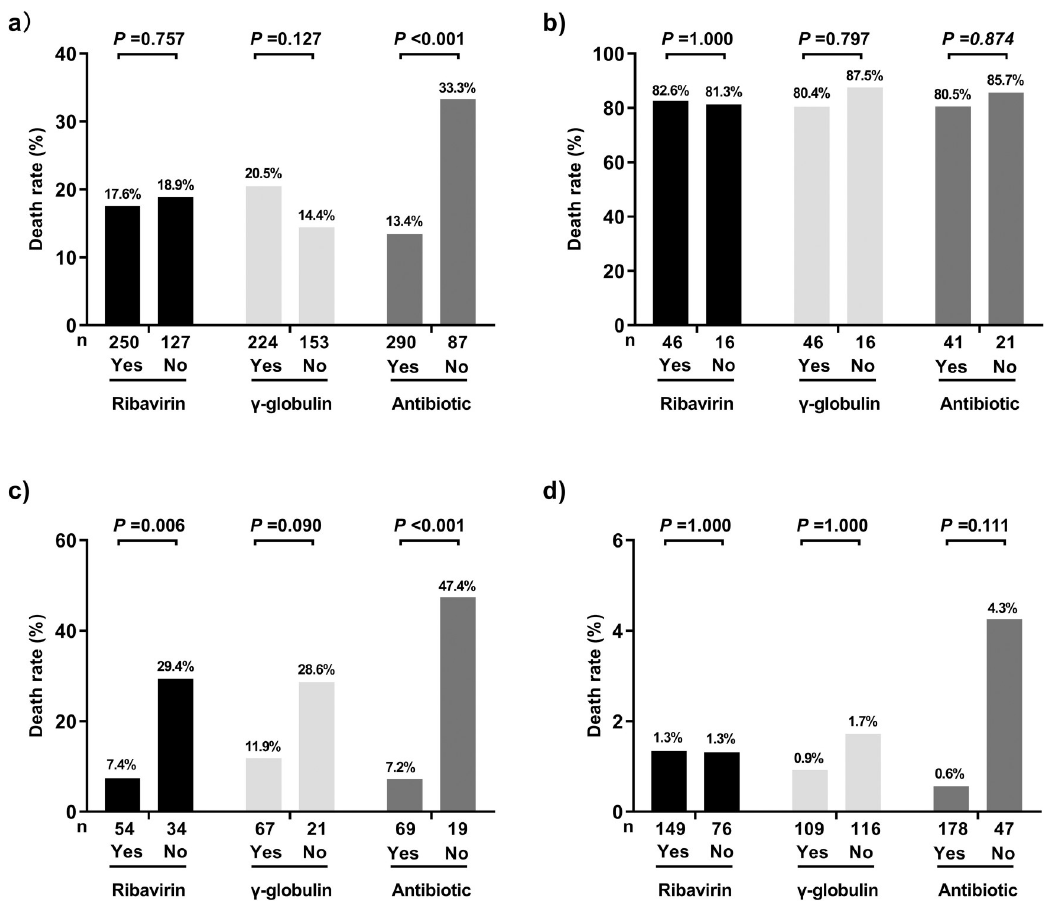
Fig 3. Analysis of the effect of three drugs on the outcome of patients with severe fever with thrombocytopenia syndrome. (A) Overall analysis. (B) Double-positive group. (C) Single-positive group. (D) Double-negative group. group (P = 0.003 in patients with infection group or agranulocytosis, and P = 0.045 in patients with non-infection and agranulocytosis, respectively) but not in the double-positive and dou- ble-negative groups (all P > 0.05). Among the 88 patients in the single-positive group who were treated with antibiotics, we assessed the WBC count, percentage of neutrophils (N%), C- reactive protein (CRP) level, and procalcitonin (PCT) level according to the presence of infec- tion and agranulocytosis. There were significant differences in the WBC count and N% (P = 0.014 and P < 0.001, respectively), but not among the other indicators, between the groups of patients with and without agranulocytosis (Fig 4). In addition, all patients with SFTS (N = 377) were divided into an infection group (including sepsis and pneumonia groups) and a non- infection group; the median WBC counts in the sepsis group (n = 17), pneumonia group (n = 142), and non-infection group (n = 223) were 4.620 × 10 9 /L, 2.035 × 10 9 /L, and 2.440 × 10 9 /L, respectively, and the WBC count statistically differed between the pneumonia group and the non-infection group (P = 0.036). The median N% values in the sepsis group (n = 18), pneumonia group (n = 144), and non-infection group (n = 224) were 0.665, 0.620, and 0.630, respectively, and there was no statistical difference between the three groups. The median CRP levels in the sepsis group (n = 16), pneumonia group (n = 134), and non-infection group (n = 214) were 18.80 mg/L, 6.015 mg/L, and 3.920 mg/L, respectively; the CRP level in